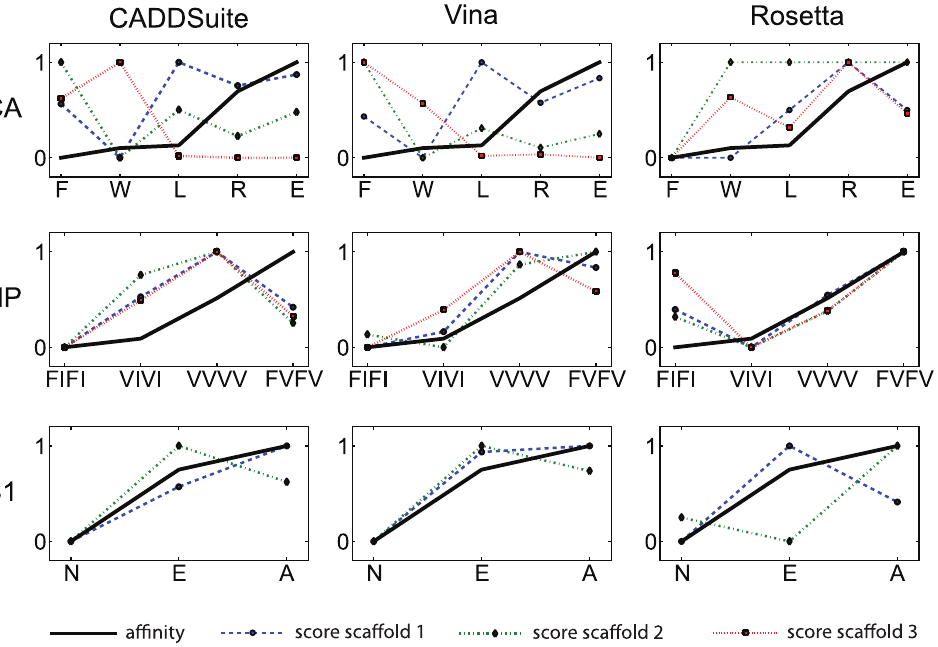
Figure 4. Comparison of the energy scores versus the affinities of the mutations show how well the programs reproduce the differences. For each test case with more than two mutations, we plotted the top binding scores of CADDSuite, Vina, and Rosetta designs for each mutation on each scaffold structure together with the logarithm of the affinity. Here we show plots for Carbonic anhydrase II, HIV-1 protease, and Streptavidin test 1. All other plots are shown in Information S1. Values are scaled to fit in the same range. Shown on the x-axis of a plot are the mutants in order of affinity to the ligand (the leftmost has the lowest affinity, compare Table 1 for the actual values). The y-axis measures predicted binding scores for the designs, and the log affinities, scaled between 0 and 1. Both are proportional to the binding free energy, and can therefore be compared when scaled to the same range. The lowest predicted binding score or log affinity is set to 0, the highest respective value to 1. Each plot contains a line for the affinity logarithm (solid, black no marker). This line represents the goal, if a method predicts binding well, the binding score lines should closely follow the log affinity line. The other markers and lines show the scaled predicted binding scores. One line represents the designs calculated for all available mutants, calculated by using one crystal structure as the scaffold. (Crystal structure 1: dashed, blue, circle markers; structure 2: red, dotted, square markers; structure 3: green, dash-dot pattern, diamond markers; structure 4: cyan, two dashes one dot pattern, star markers). We chose to use lines for representation, because this makes it easy to visually compare the shape of the black log affinity line to the lines representing the design binding scores. Each row has plots for one test case, in parentheses the order of scaffold structures is listed: CA : Carbonic anhydrase II (1ydb, 1yda, 1ydd), HP : HIV-1 protease (1met, 1meu, 1mes), S1 : Streptavidin test 1 (1swe, 1n43).